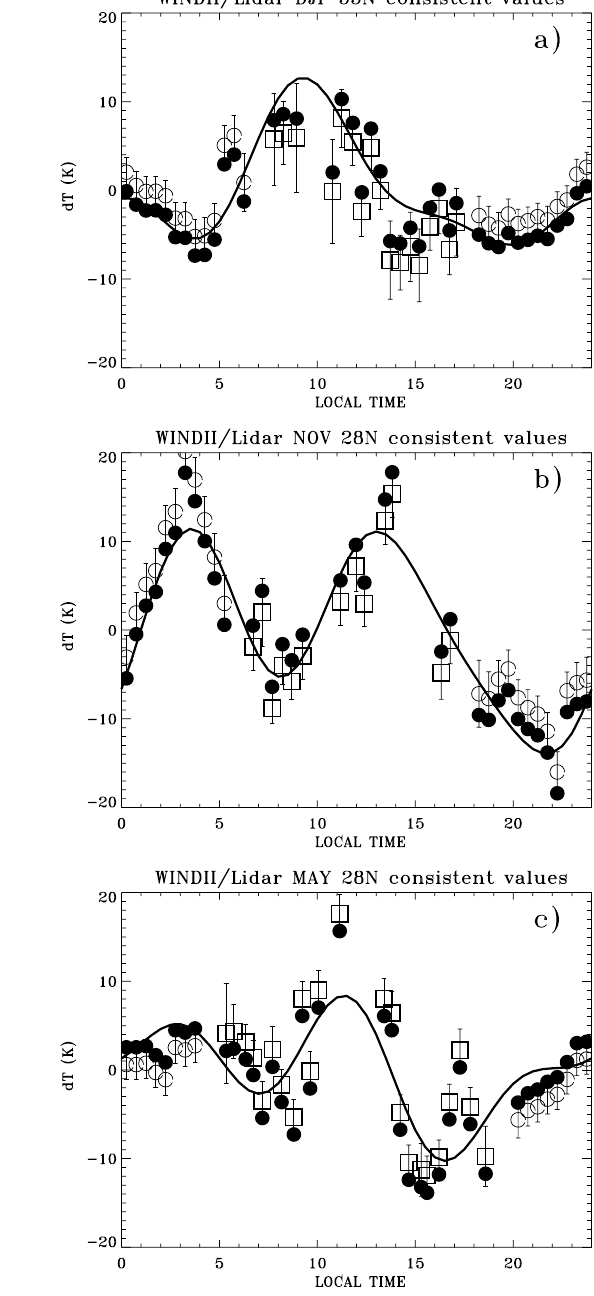
Fig. 6. Combined (24h+12h+8h) tidal fit (solid line) to the potassium-lidar nighttime temperatures (open circles) and the WINDII daytime temperatures (open squares) after applying the consistency test (the corrected data are in solid circles) for: (a) December-February; (b) November, and (c) May. servations at mid latitudes, 40 ◦ N–45 ◦ N have provided in- formation on the diurnal variability of the temperature field (i.e. States and Gardner, 1998, 2000a, b; Chen et al., 2000; Williams et al., 1998). Williams et al. (1998) presented esti- mates of the annual nighttime temperature variability